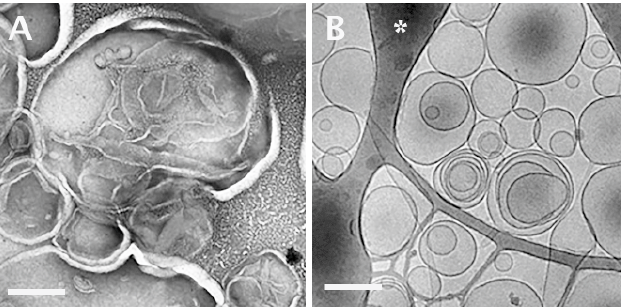
Figure 1. TEM images of the exogenous lung surfactant, Curosurf ® : ( A ) a room-temperature specimen prepared by staining with a uranyl acetate solution and drying; ( B ) a cryo-TEM image of the same system. The dark domains in ( B ) are parts of the perforated carbon film (asterisk). Scale bars correspond to 200 nm. Adapted from [46].